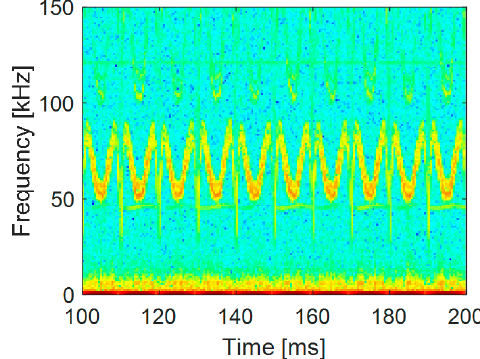
Figure 11. Case study 3: Time-frequency representation obtained by means the spectrogram with 1 kHz frequency resolution and 1 ms time resolution.